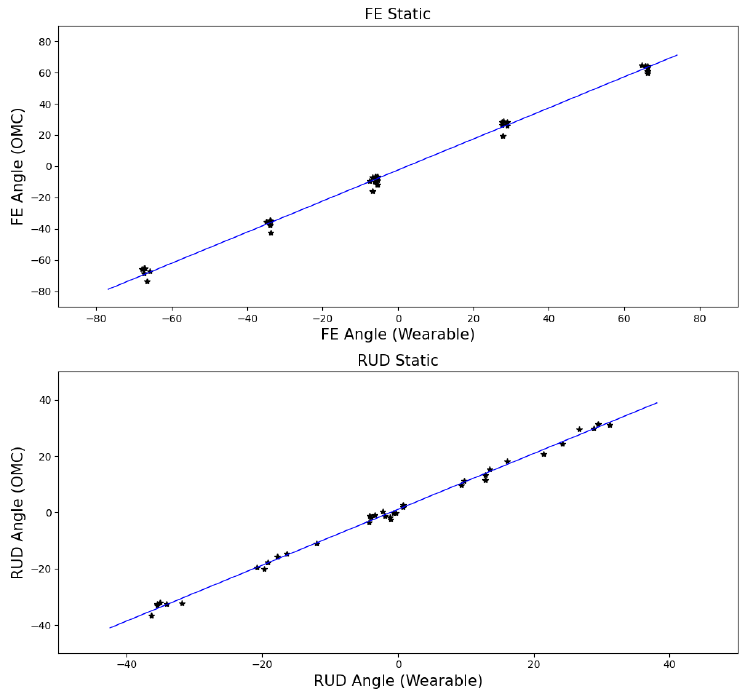
Figure 6. Correlation between the optical motion capture and wearable device during benchtop testing.